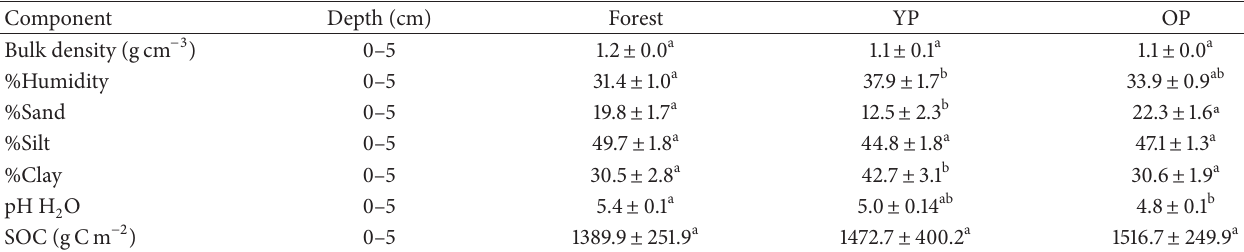
Table 1: Soil properties in the study sites (according to Gonz´alez-Pedraza and Dezzeo [24, 25]). Component